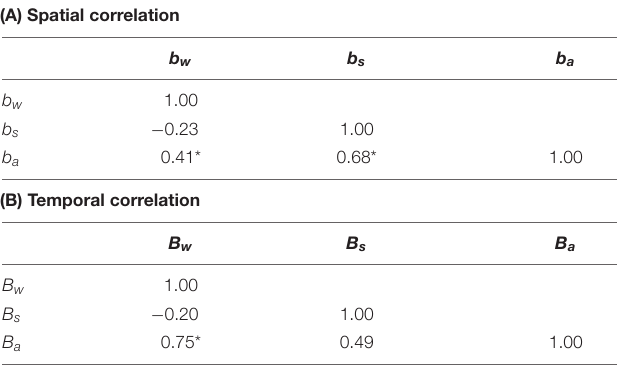
TABLE 1 | Pearson correlation coefficients between mass balance components.